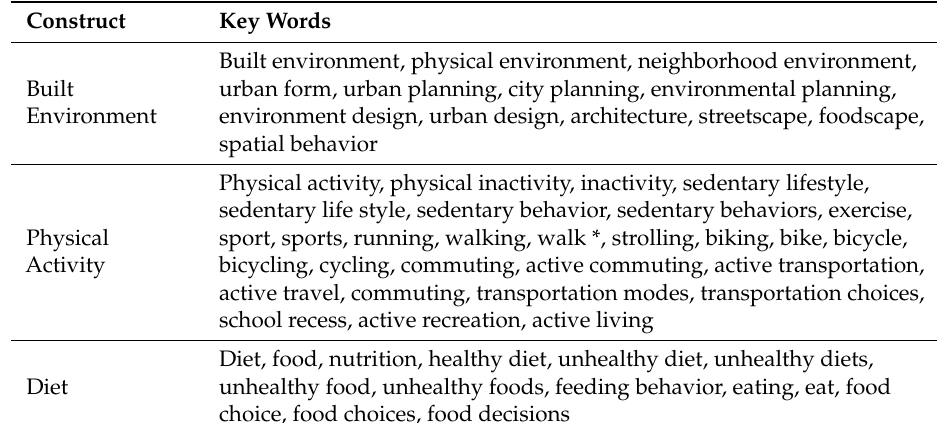
Table 1. Keywords used in the search